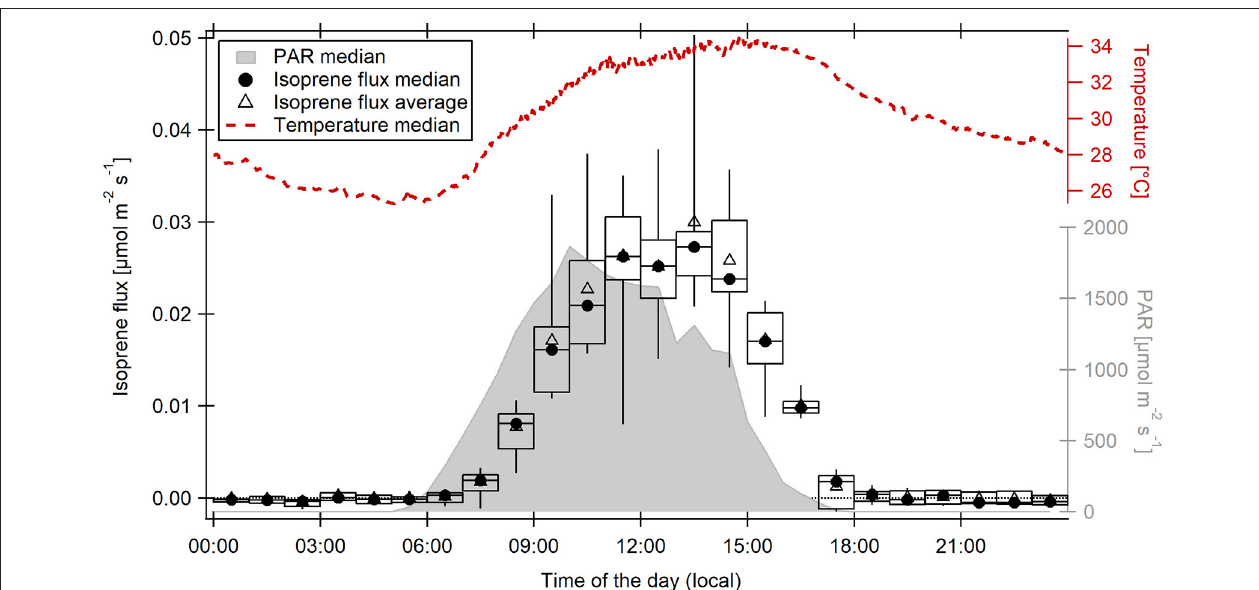
FIGURE 5 | Diel hourly averages and medians of isoprene fluxes measured at 41m above ground level at the ATTO site between November 11 and 23, 2015. Boxes and whiskers represent the 25–75th and 5–95th percentiles, respectively. The diel medians of photosynthetic active radiation (PAR) and ambient temperature measured at the same height are displayed on the right